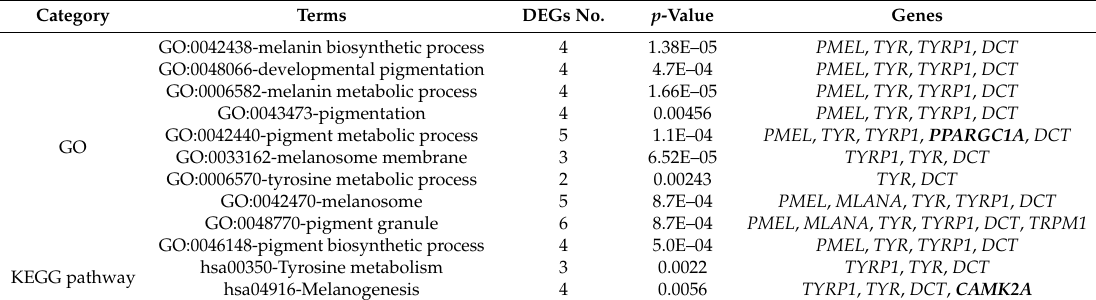
Table 3. Significantly enriched GO terms and KEGG pathways related to skin or hair follicle pigmentation. Bold italic and italic text respectively indicate higher and lower expression of differentially expressed genes (DEGs) in white skin compared to black